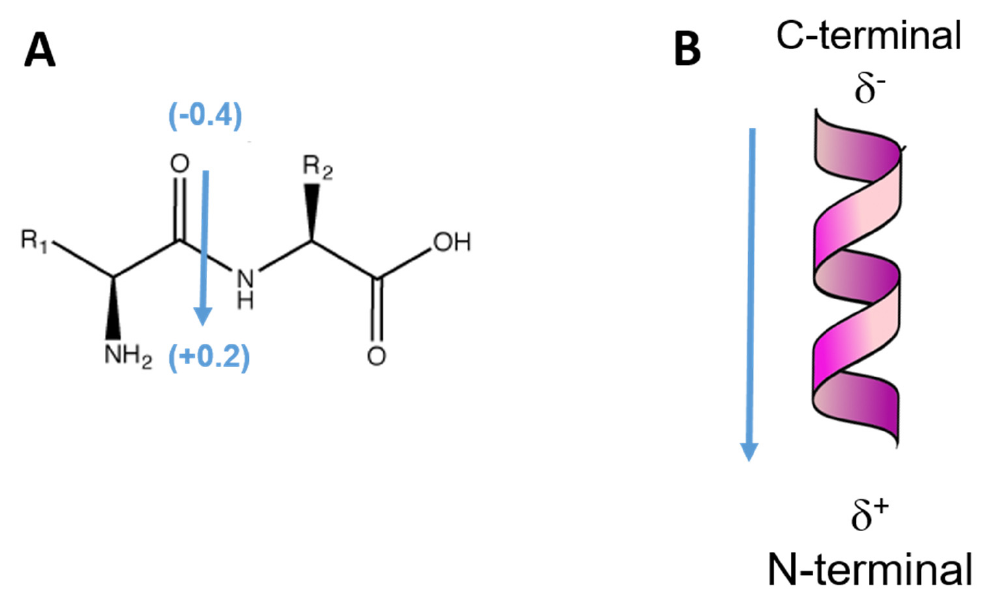
Figure 2. ( A ) Dipole moment of the peptide bond and ( B ) alignment of all the dipoles along the helix axis in a helical conformation.